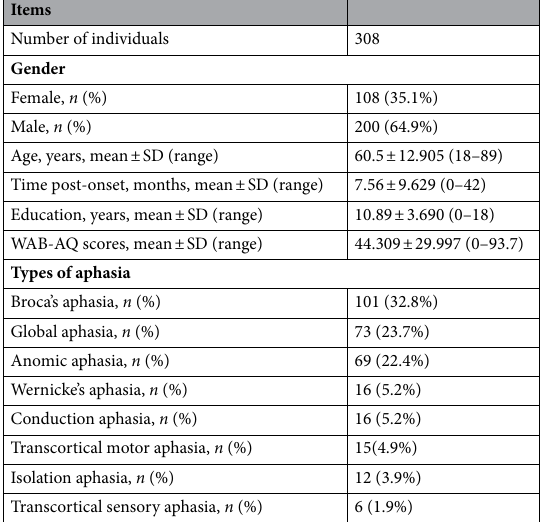
Table 1. Baseline characteristics of participants. SD standard deviation, WAB-AQ aphasia quotient of Western Aphasia Battery.